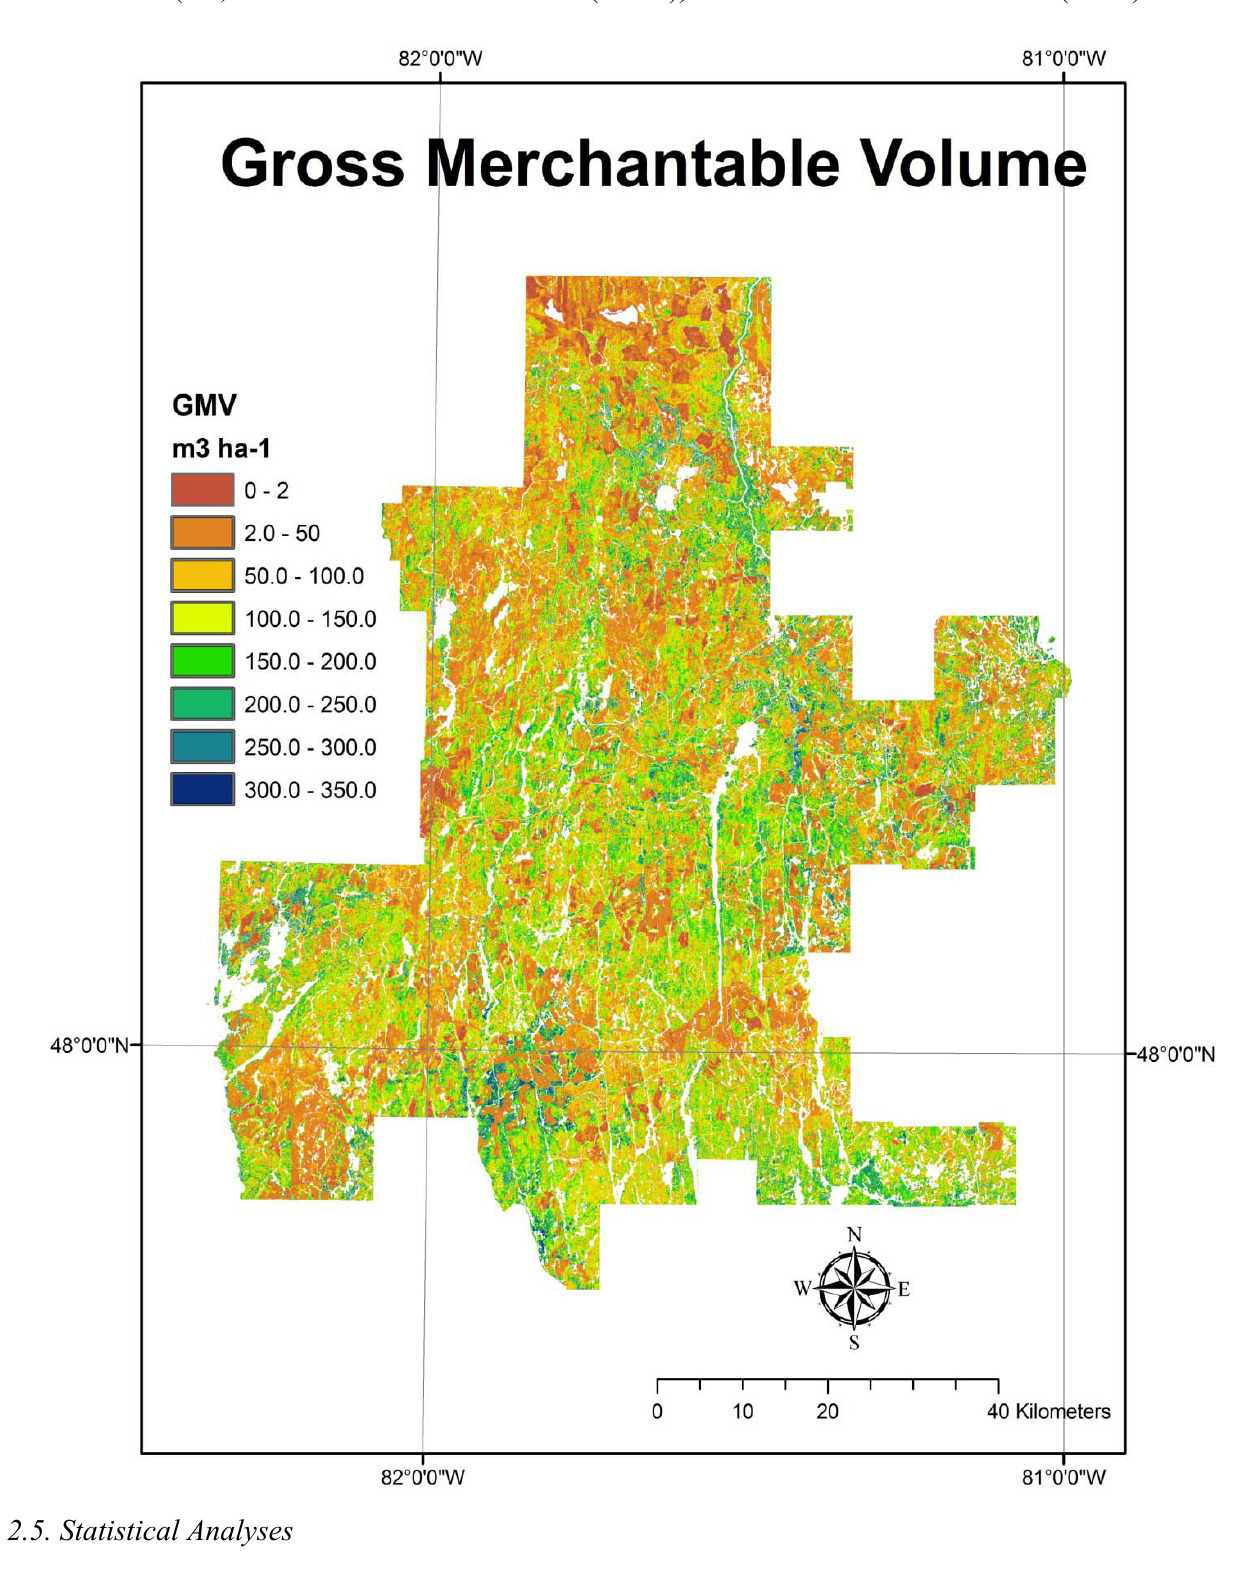
Figure 3. Sample model predicted surface generated from LiDAR height and